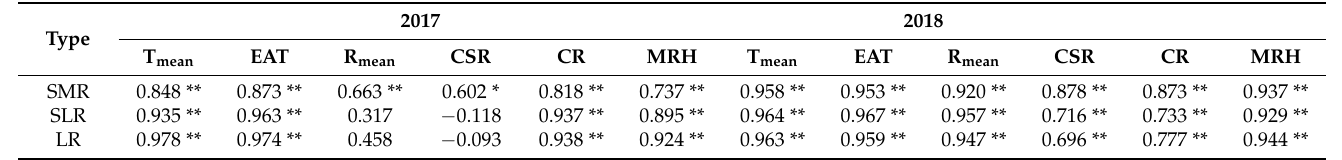
Table 7. Correlation between CEQ and meteorological indicators 1